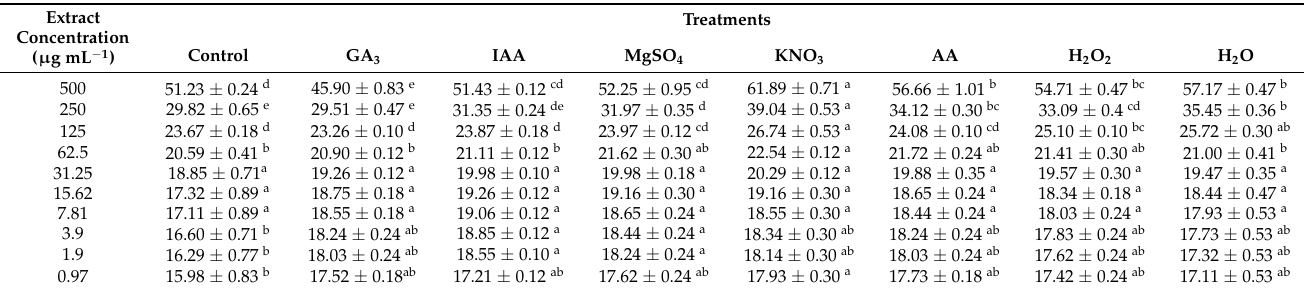
Table 4. DPPH inhibition (%) in the aboveground part of wheat seedlings after different priming